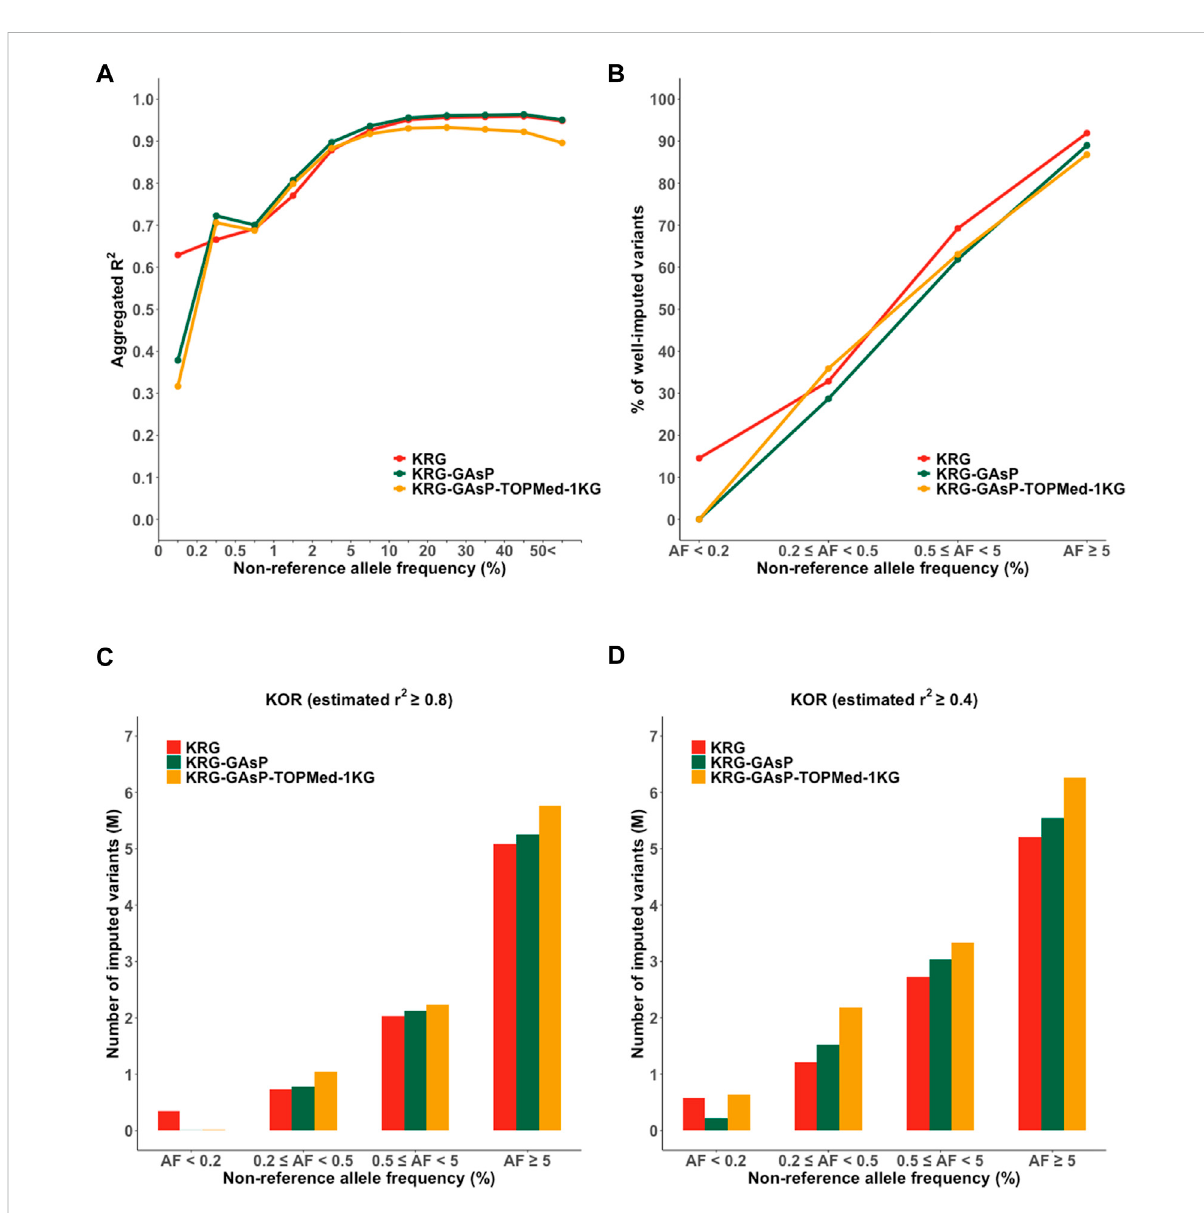
FIGURE 5 Performance of meta-imputation. Imputation quality metrics for the Korea (KOR) genotype panel mimicking KBA were measured; (A) aggregated R 2 , (B) % of well-imputed variants (estimated r 2 ≥ 0.8), and (C) number of imputed variants (estimated r 2 ≥ 0.8), and (D) # of imputed variants (estimated r 2 ≥